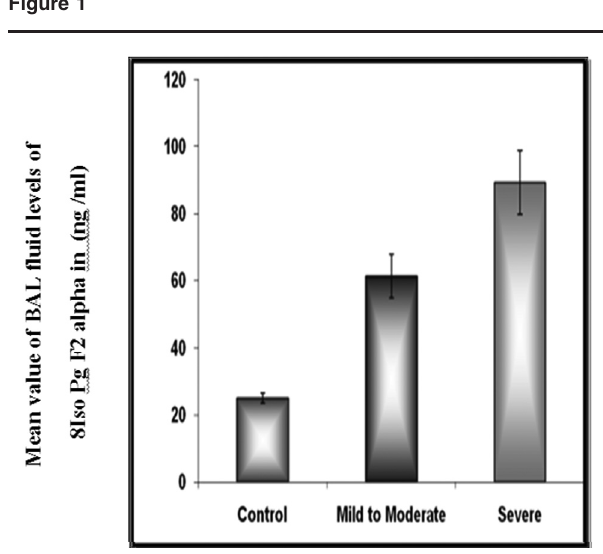
Bronchoalveolar lavage fluid and serum levels of transforming growth factor β 1 (ng/ml)